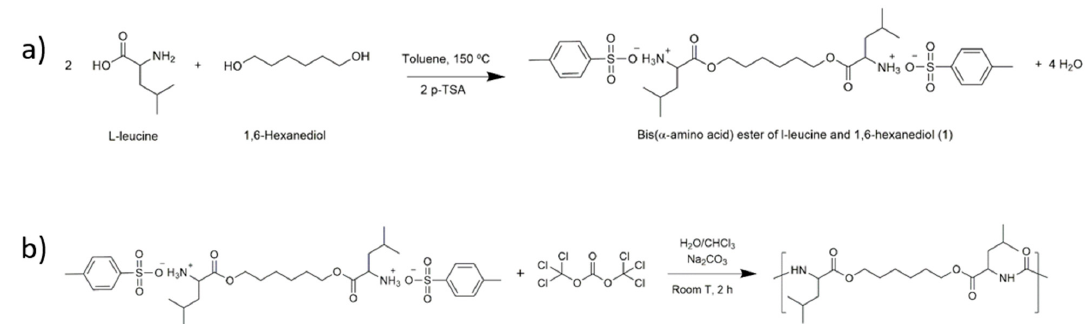
Figure 1. A representation of the chemical synthesis of PEU including ( a ) synthesis of bis( α -amino acid) ester from L -leucine and 1,6-hexanediol and ( b ) the reaction between bis( α -amino acid) ester from L -leucine and 1,6-hexanediol and triphosgene to yield the L -leucine-based PEU.